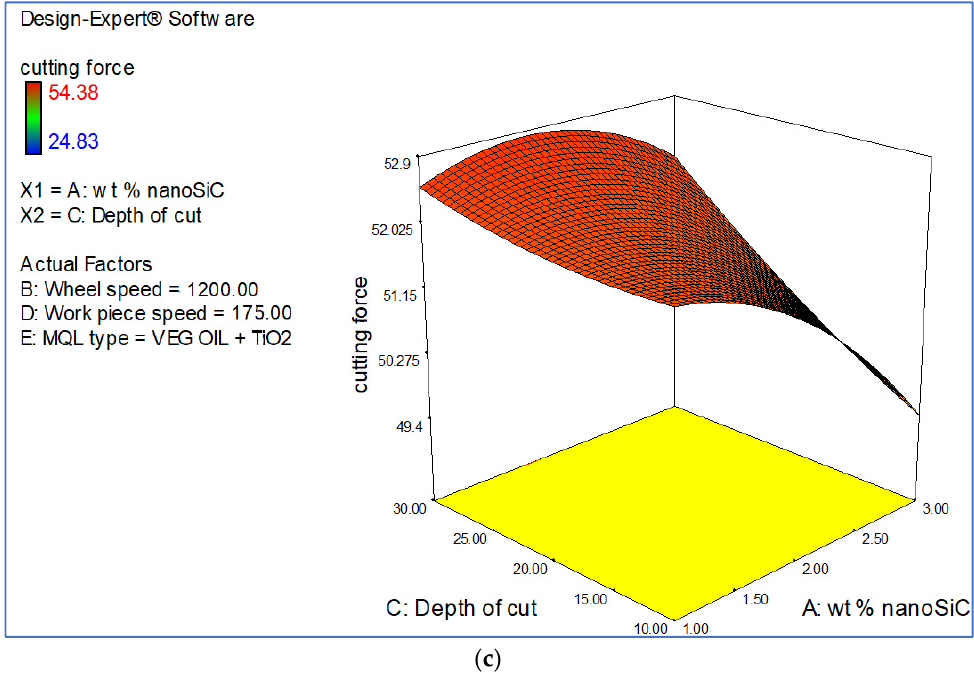
Figure 8. ( a ) 3D response plot for CF on wt % of nano-SiC vs. depth of cut under SAE20W40. ( b ) 3D response plot for CF on wt % of nano-SiC vs. depth of cut under veg oil. ( c ) 3D response plot for CF on wt % of nano-SiC vs. depth of cut under veg oil + TiO 2 .